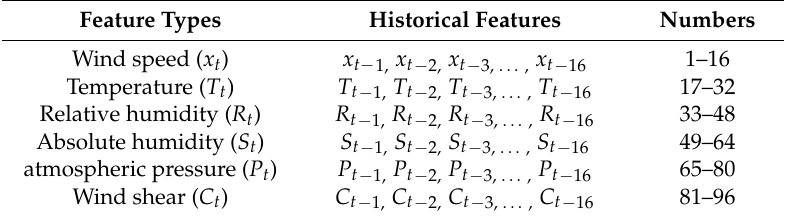
Table 1. The original historical feature set and the features’ serial number.